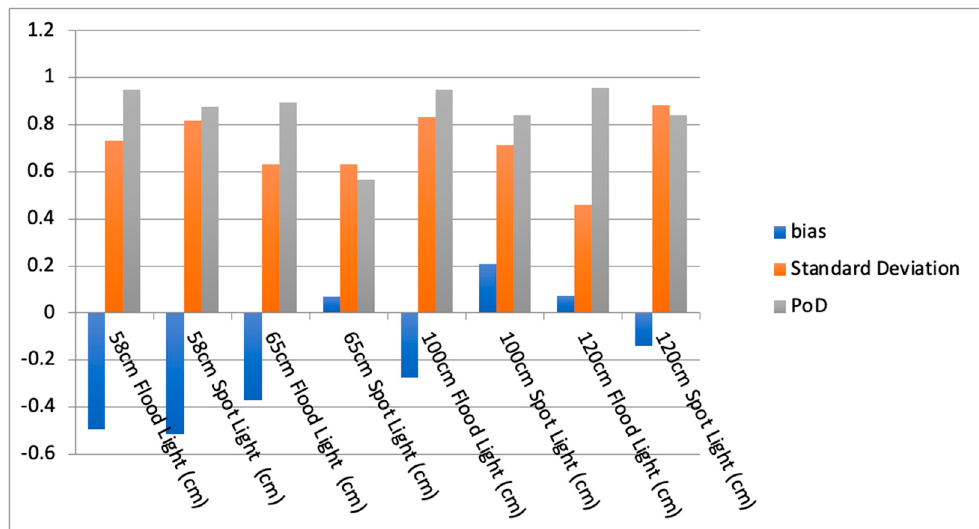
Figure 17. PoD, bias, and standard deviation of error for each protocol.